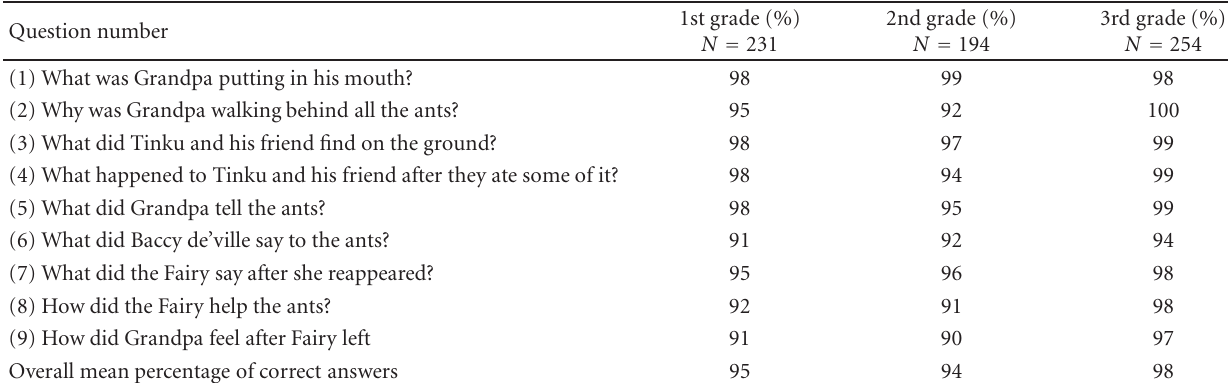
Table 4: Percentage of correct responses to the 4–6 week followup questionnaire by